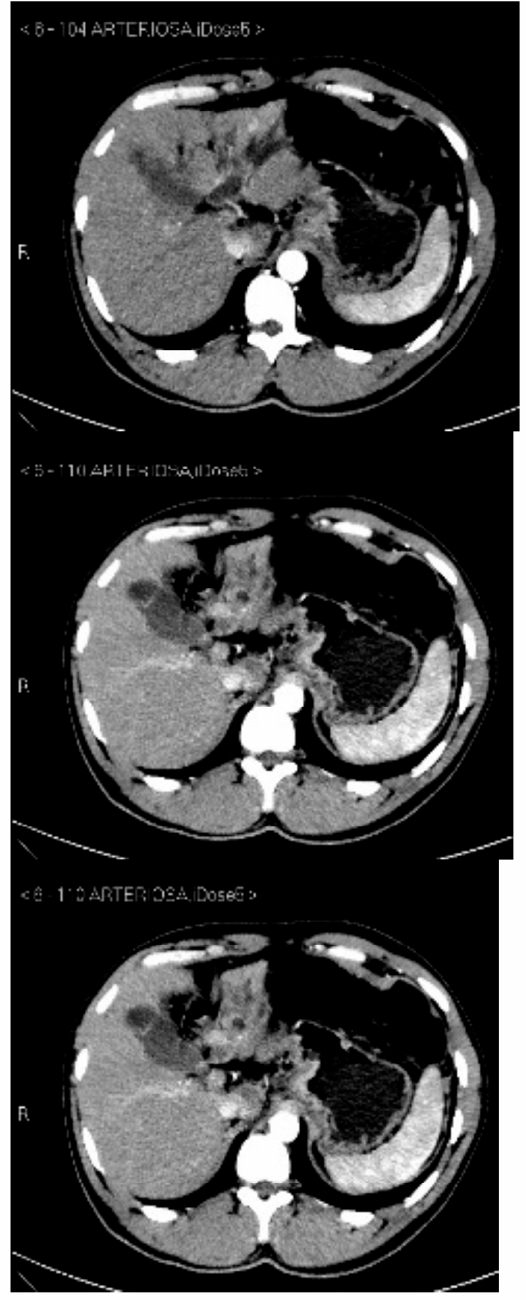
Figure 1. CT arterial phase.